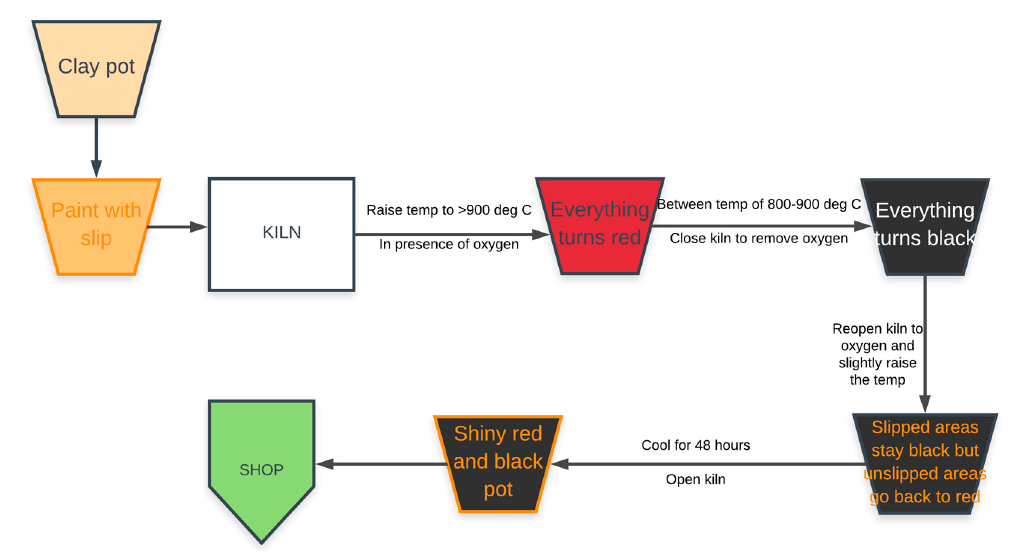
Figure 1. The single three-phase firing as described by J. V. Noble ([1965] 1988).